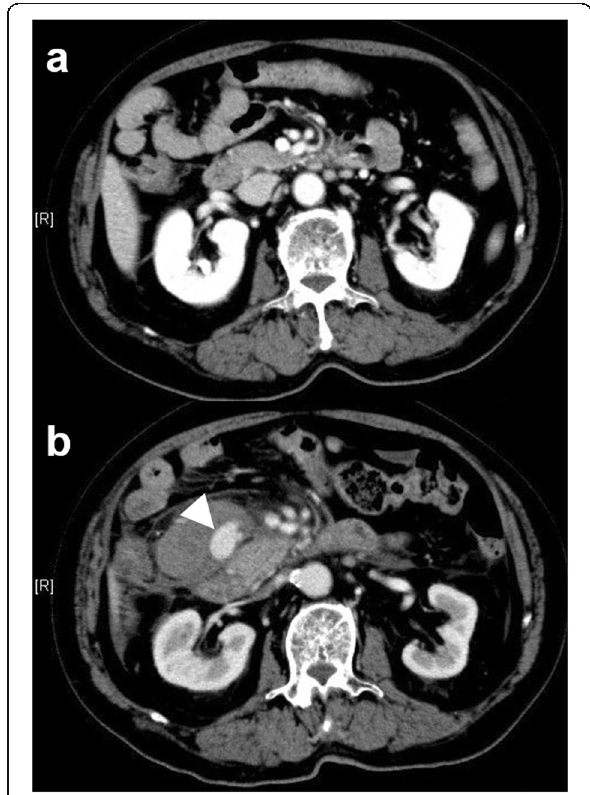
Fig. 1 Contrast-enhanced computed tomography (CT) findings at the previous hospital. a CT examination at admission to the previous hospital showed no abnormal findings around the superior mesenteric artery and vein or the duodenum. b CT images obtained on the fourth day after symptom onset demonstrated a newly developed hematoma with a pseudoaneurysm (white arrowhead) in the mesentery of the duodenum